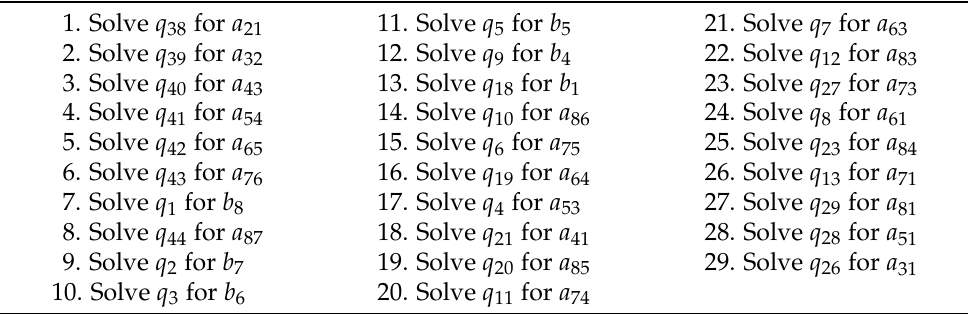
Table 1. The order in which the equations are solved, followed by the variable for which each one is